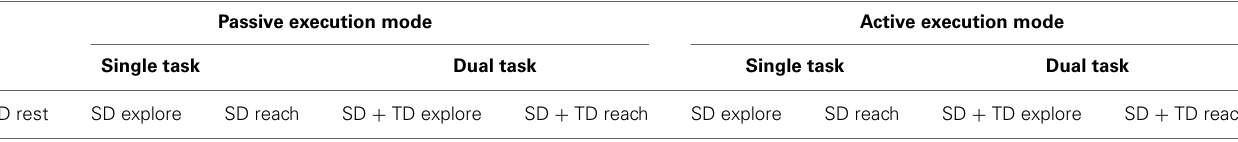
Table 1 | Summary of experimental